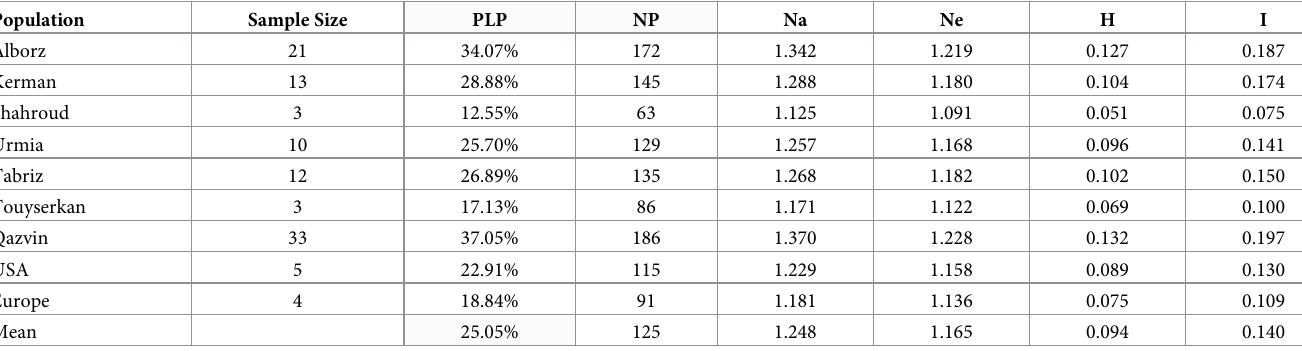
Table 2. Estimated genetic diversity of nine walnut germplasm populations.